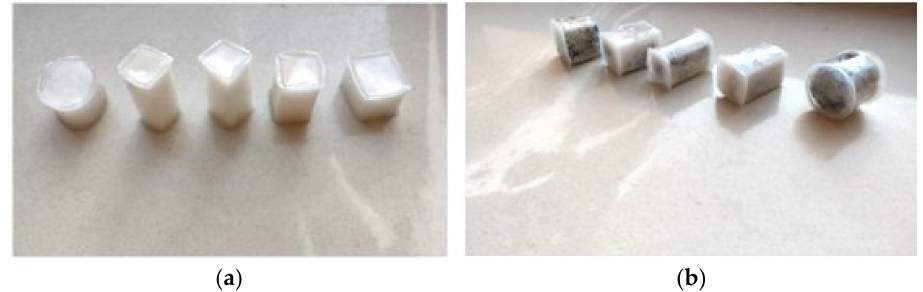
Figure 7. ( a ) Experimental samples containing pure PCM; ( b ) test samples containing PCM with carbon